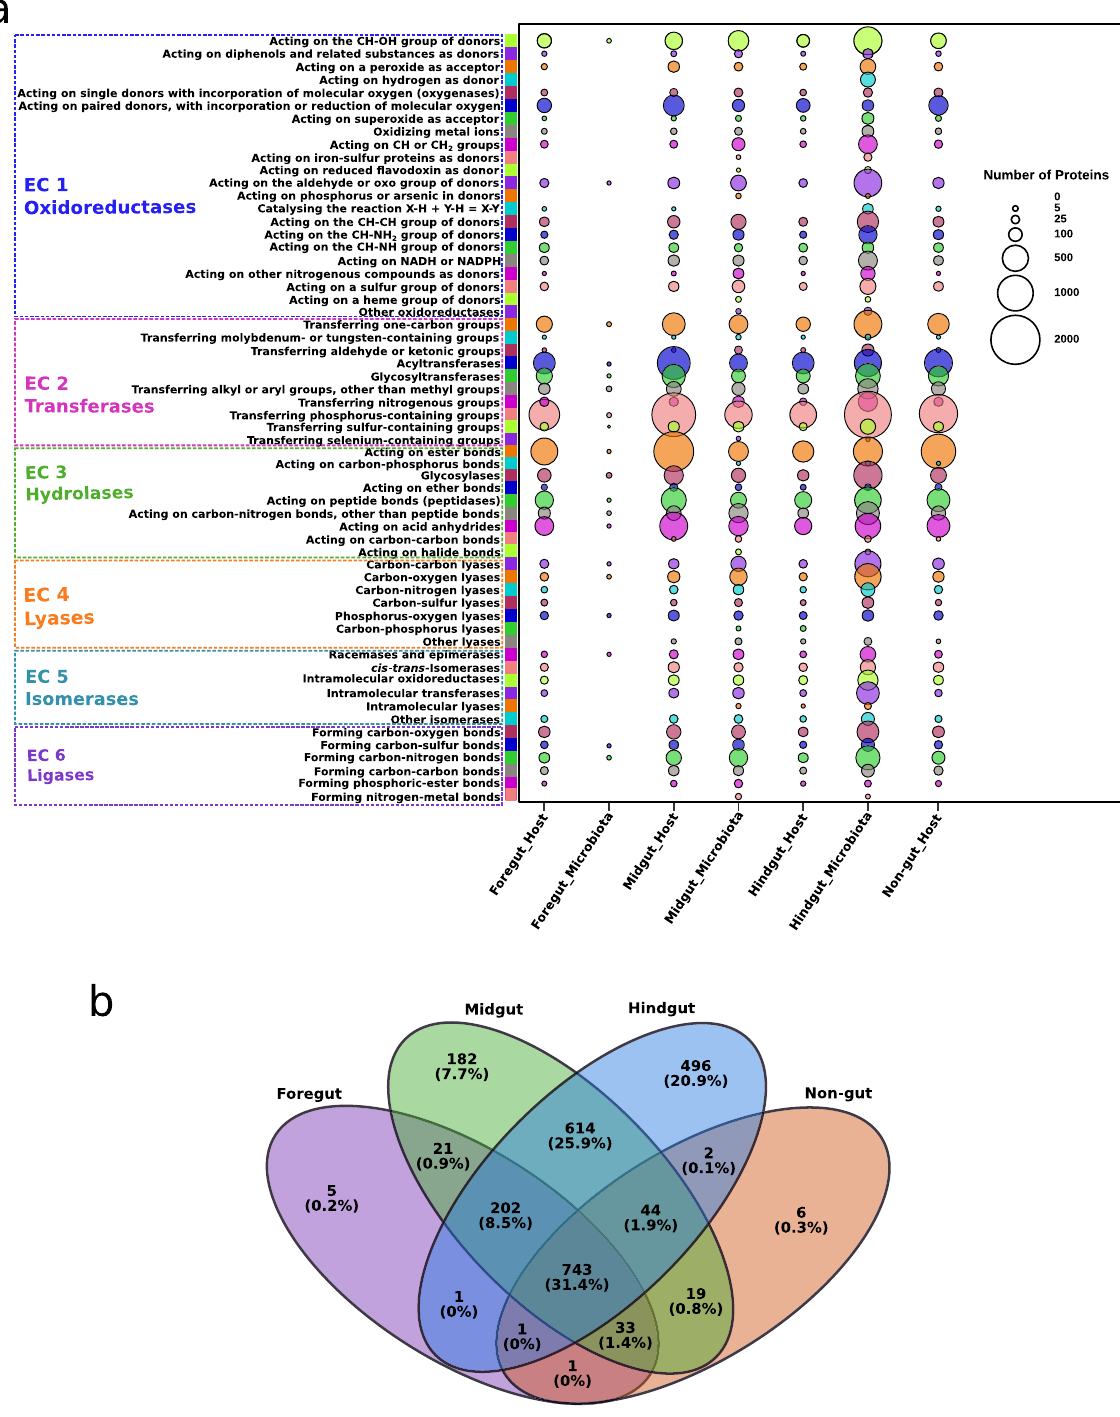
Figure 4. ( a ) Abundance and distribution of proteins, classified according to the enzyme classes in the millipede holobiont. The bubble size depicts the enzyme expression level. ( b ) Venn diagram of the distribution and abundance of enzyme classes at fourth level classification (i.e. EC x.x.x.x, “x” being any number according to the Enzyme Commission number) in different tissues in the millipede holobiont. Unique and shared enzymes are shown in number and percentage (up to one